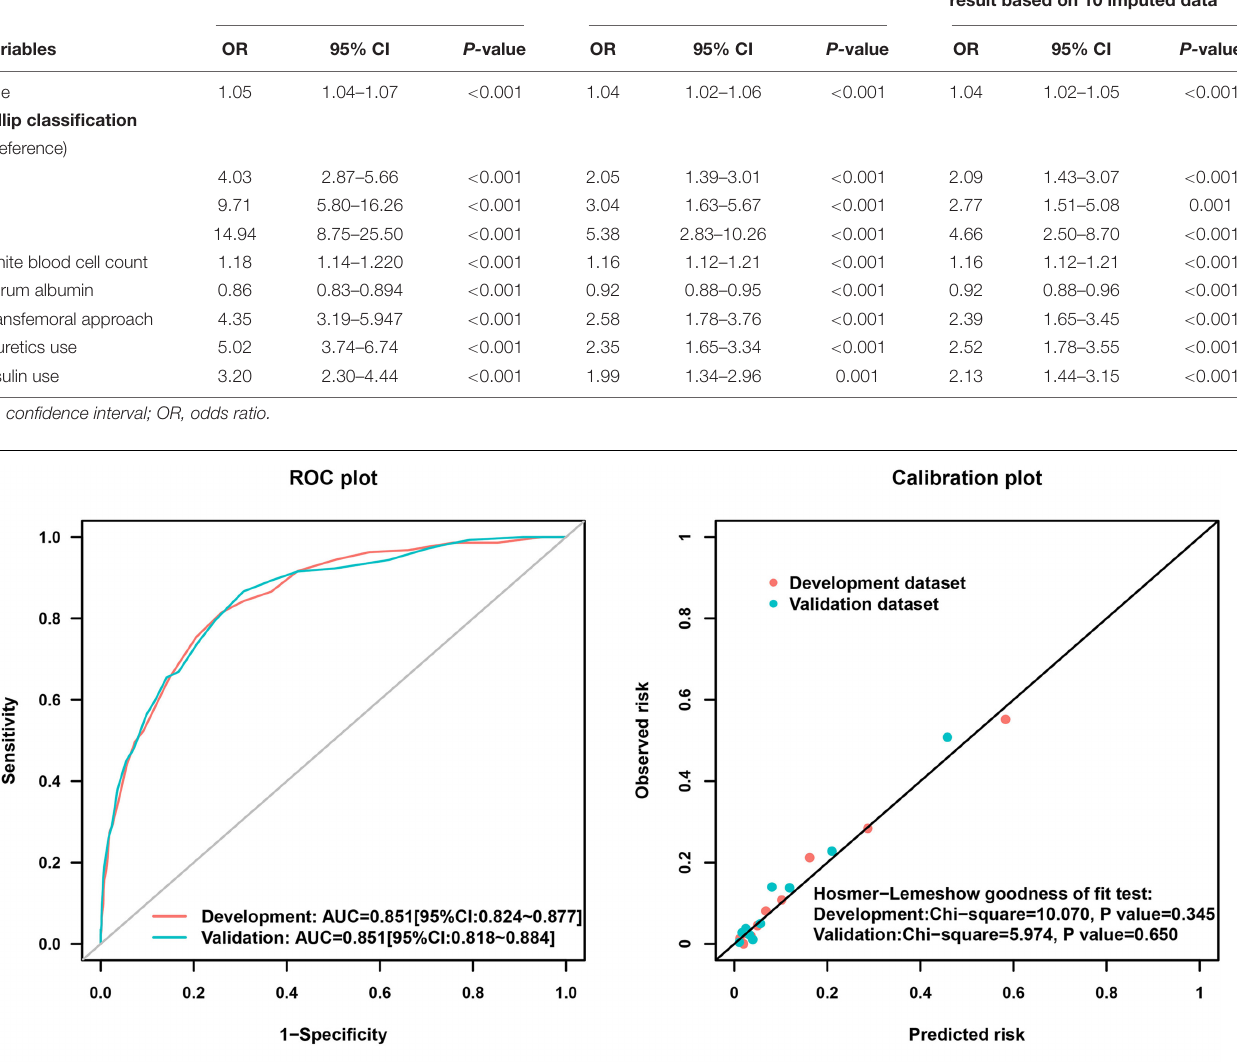
the present risk score showed a similar predictive effect on infection between patients with (AUC:0.816, 95% CI:0.779– 0.854) and without (AUC:0.789, 95% CI:0.724–0.854) use of